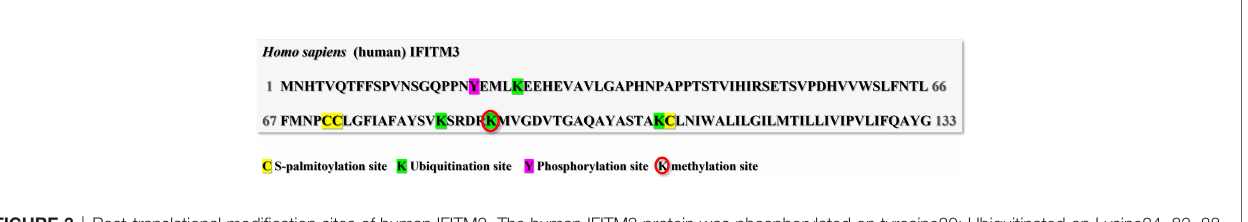
FIGURE 3 | Post-translational modi fi cation sites of human IFITM3. The human IFITM3 protein was phosphorylated on tyrosine20; Ubiquitinated on Lysine24, 83, 88 and 104; methylated on Lysine88; and S-palmitoylated on cysteine71,72